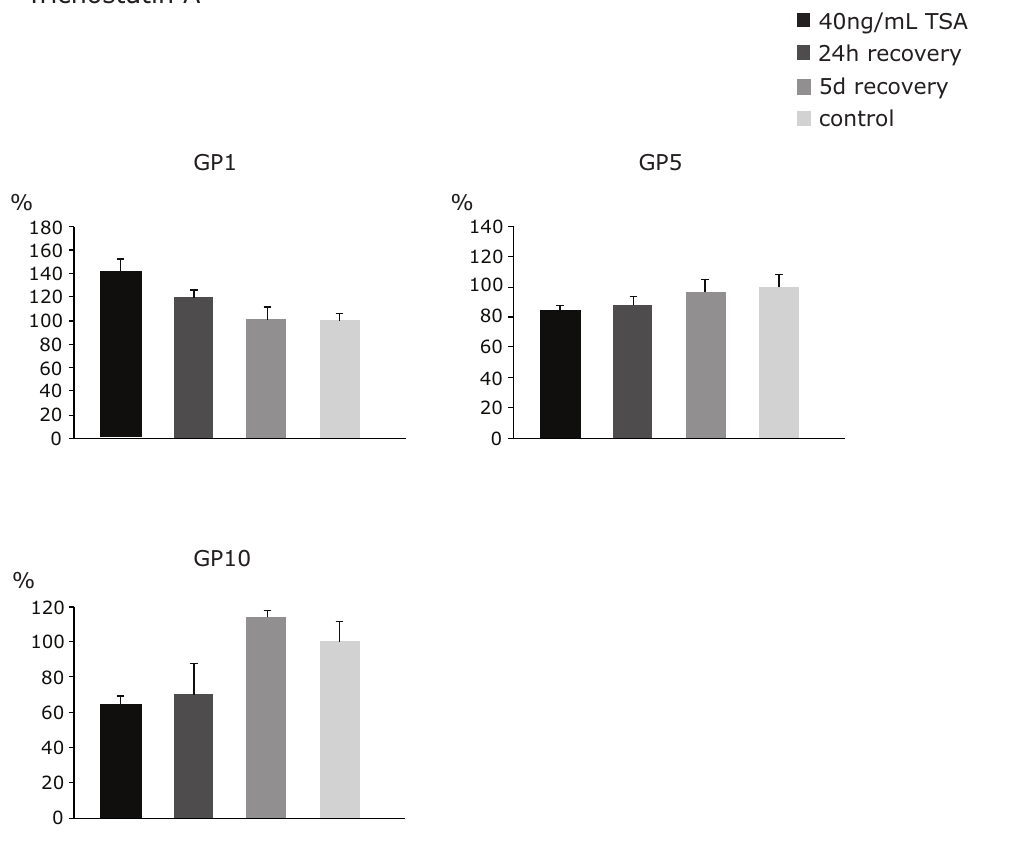
Figure 5. Changes in mean contributions of glycan groups GP1, GP5 and GP10 following TSA treatment and recovery. The observed changes were normalized to control values, which were set to 100%. The error bars represent standard deviations obtained on the basis of 4 independent experiments.